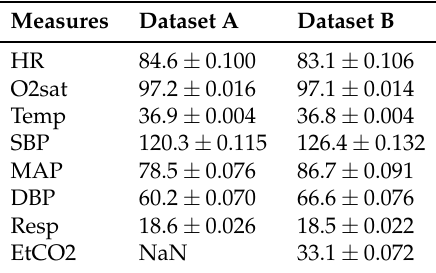
Table 1. Average values of vitals and their standard